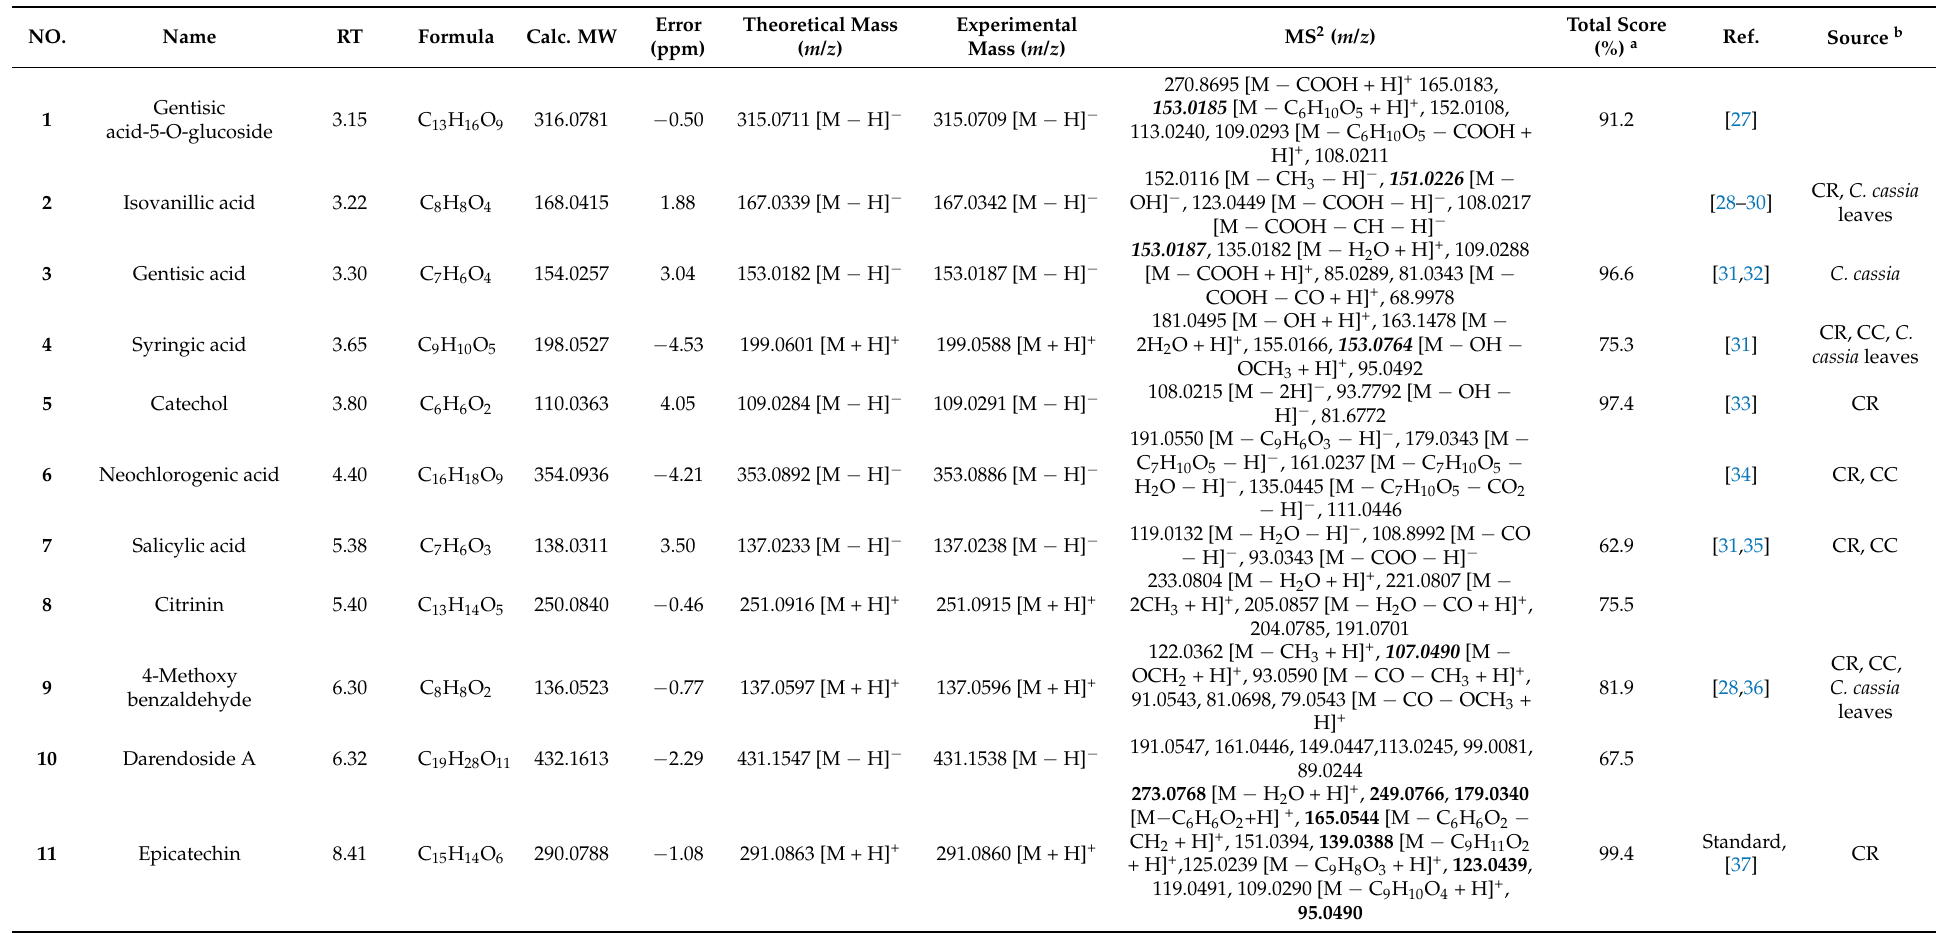
Table 1. Identification of chemical constituents in CR and